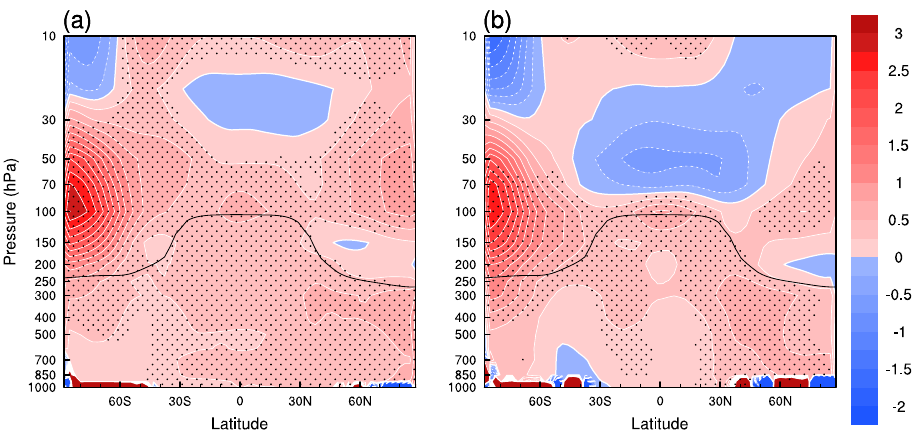
Fig. 6. Differences of annual and zonal mean temperature trends over 2001–2050 (a) between AR4-O 3 and AR4-NO-O 3 models, and (b) between CCMVal-1 and AR4-NO-O 3 models. Colour interval is 0.25K per 50yr, pink: positive, and blue: negative. Black lines in the plots indicate the climatological position of the